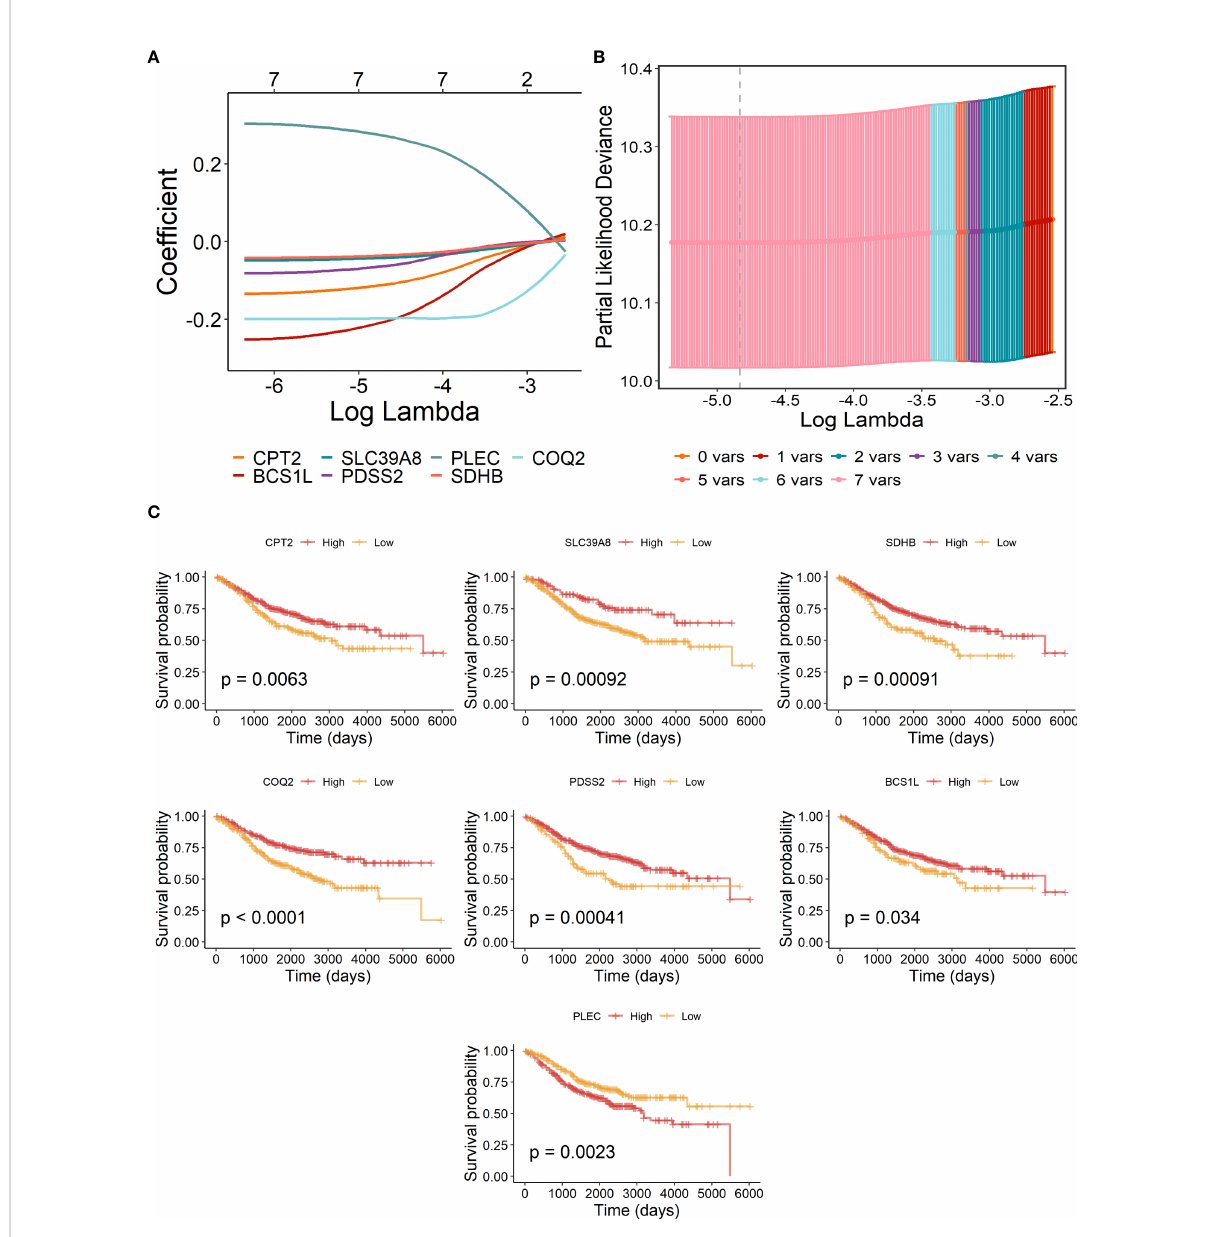
FIGURE 2 Construction of lactate-metabolism-related prognostic signature for COAD patients of the GSE40967 training group. (A) LASSO Cox regression analysis of the eight prognostic LMRGs. (B) Partial likelihood deviance for the LASSO regression to determine seven optimal prognostic LMRGs. (C) KM survival analyses of OS on the basis of mRNA expression levels of 7